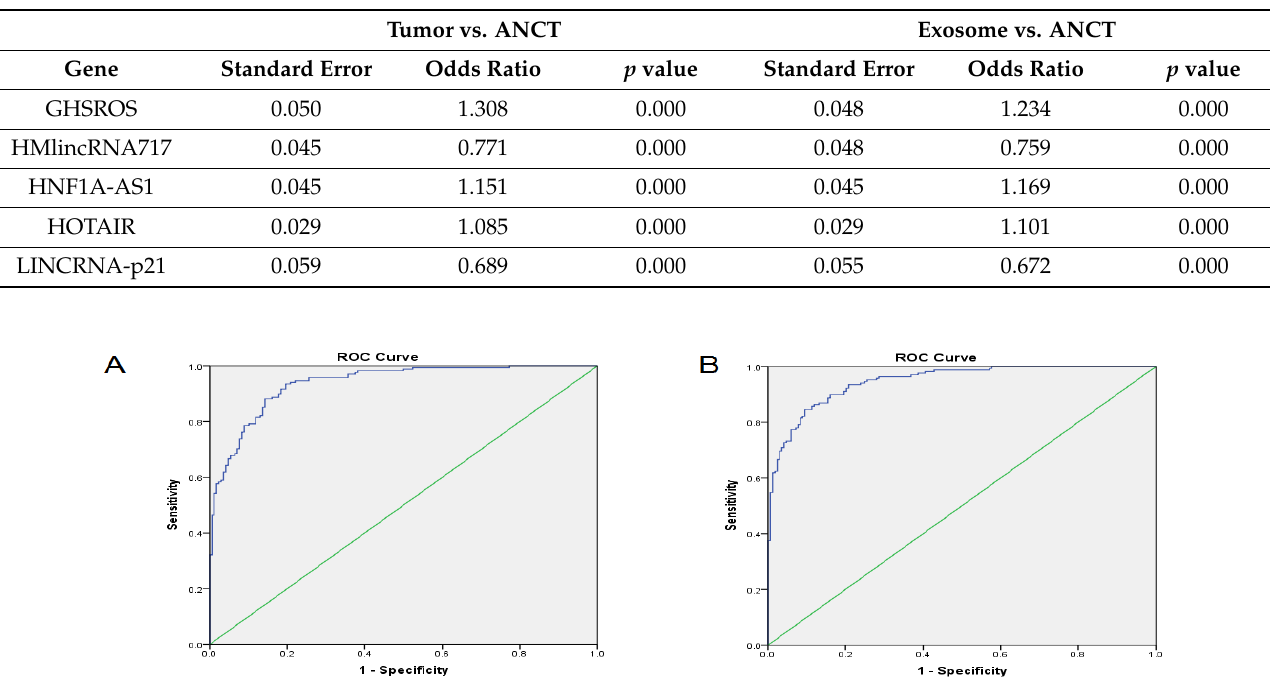
Table 4. Binary regression model results.